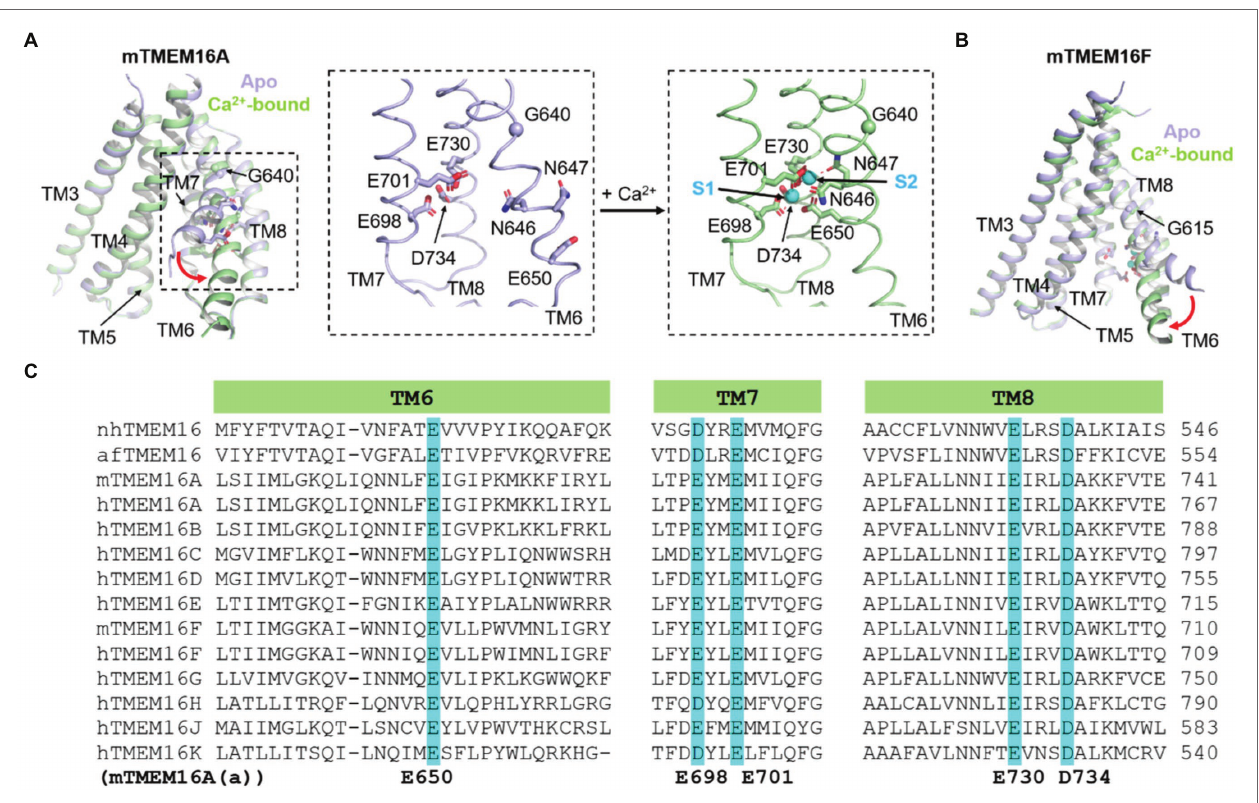
FIGURE 2 | Ca 2+ -dependent activation of TMEM16A CaCC and TMEM16F CaPLSase. (A) Ca 2+ -induced conformational changes of TMEM16A. Insets show close- up views of the Ca 2+ binding sites of TMEM16A. S1 and S2 refer the lower and upper bound Ca 2+ ions, respectively. (B) Ca 2+ -induced conformational changes of TMEM16F. The Ca 2+ -free (apo) structures are shown in light blue, and the Ca 2+ -bound structures are in light green. PDB codes are 5OYG and 5OYB for apo and Ca 2+ -bound mouse TMEM16A, respectively, and are 6QPB and 6QP6 for apo and Ca 2+ -bound mouse TMEM16F, respectively. Only TMs 3–8 are shown for clarity. (C) Protein sequence alignment of the fungal nhTMEM16 and afTMEM16 and human (h) and murine (m) TMEM16A-K showing the highly conserved Ca 2+ binding residues in TM6, 7 and 8 (highlighted in cyan). Numbering of TMEM16A’s Ca 2+ binding residues is based on the (a)